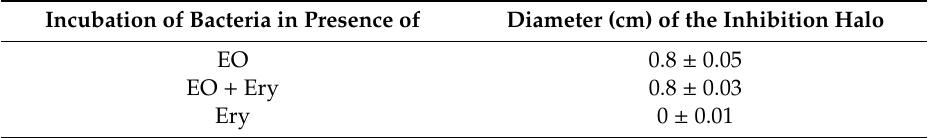
Table 3. Results of the disc di ff usion antibiotic sensitivity assays. The diameter of the inhibition halos around the disk, previously soaked with EO and EO + Ery, is